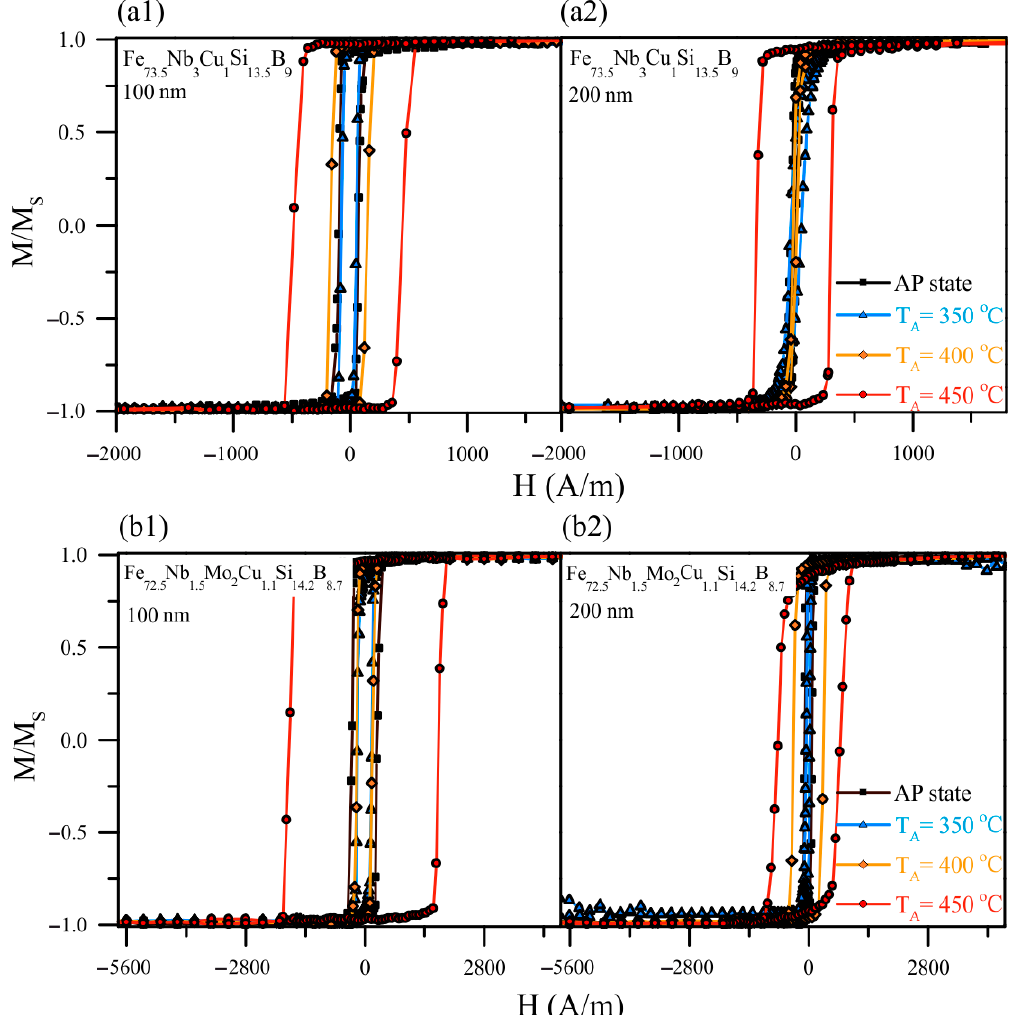
Figure 7. Hysteresis loops of the of Fe 73.5 Nb 3 Cu 1 Si 13.5 B 9 ( a ) and Fe 72.5 Nb 1.5 Mo 2 Cu 1.1 Si 14.2 B 8.7 ( b ) films with thicknesses of 100 and 200 nm in the as-prepared state and after annealing measured in the direction of the EMA.